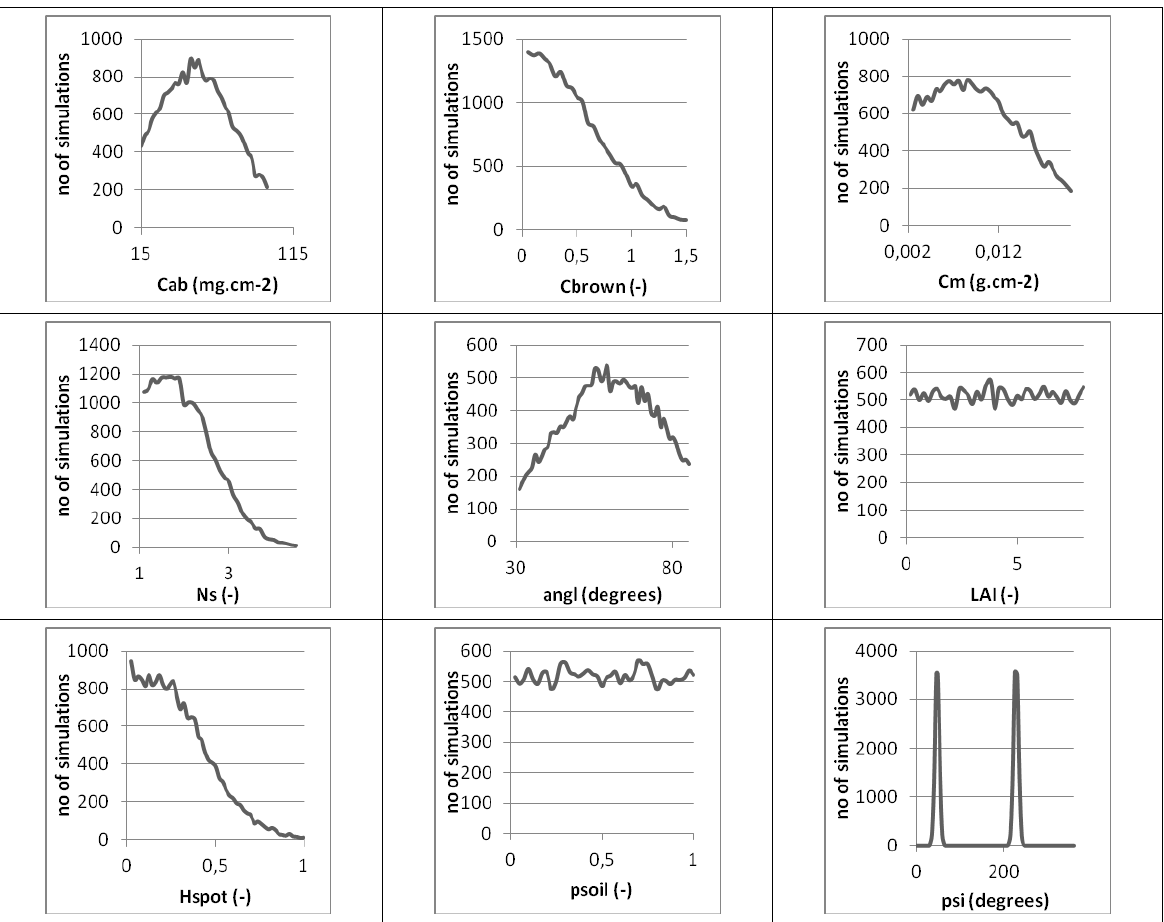
Figure 1. Histograms of the actual values used for the various input parameters of PROSPECT and SAIL to generate the